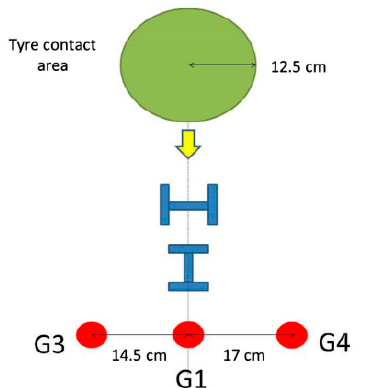
Figure 17. Lateral position of geophones G1, G3, and G4 installed on a French motorway (figures are reproduced from Duong et al. [46]).